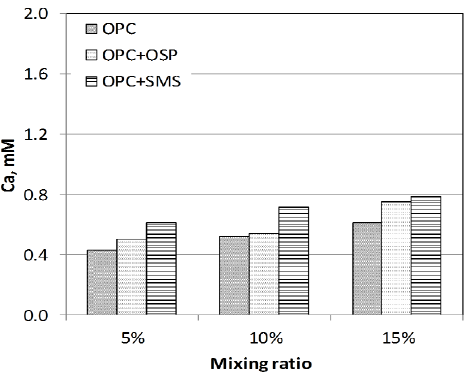
Figure 8. Ca content of mixtures with type of admixtures after 28